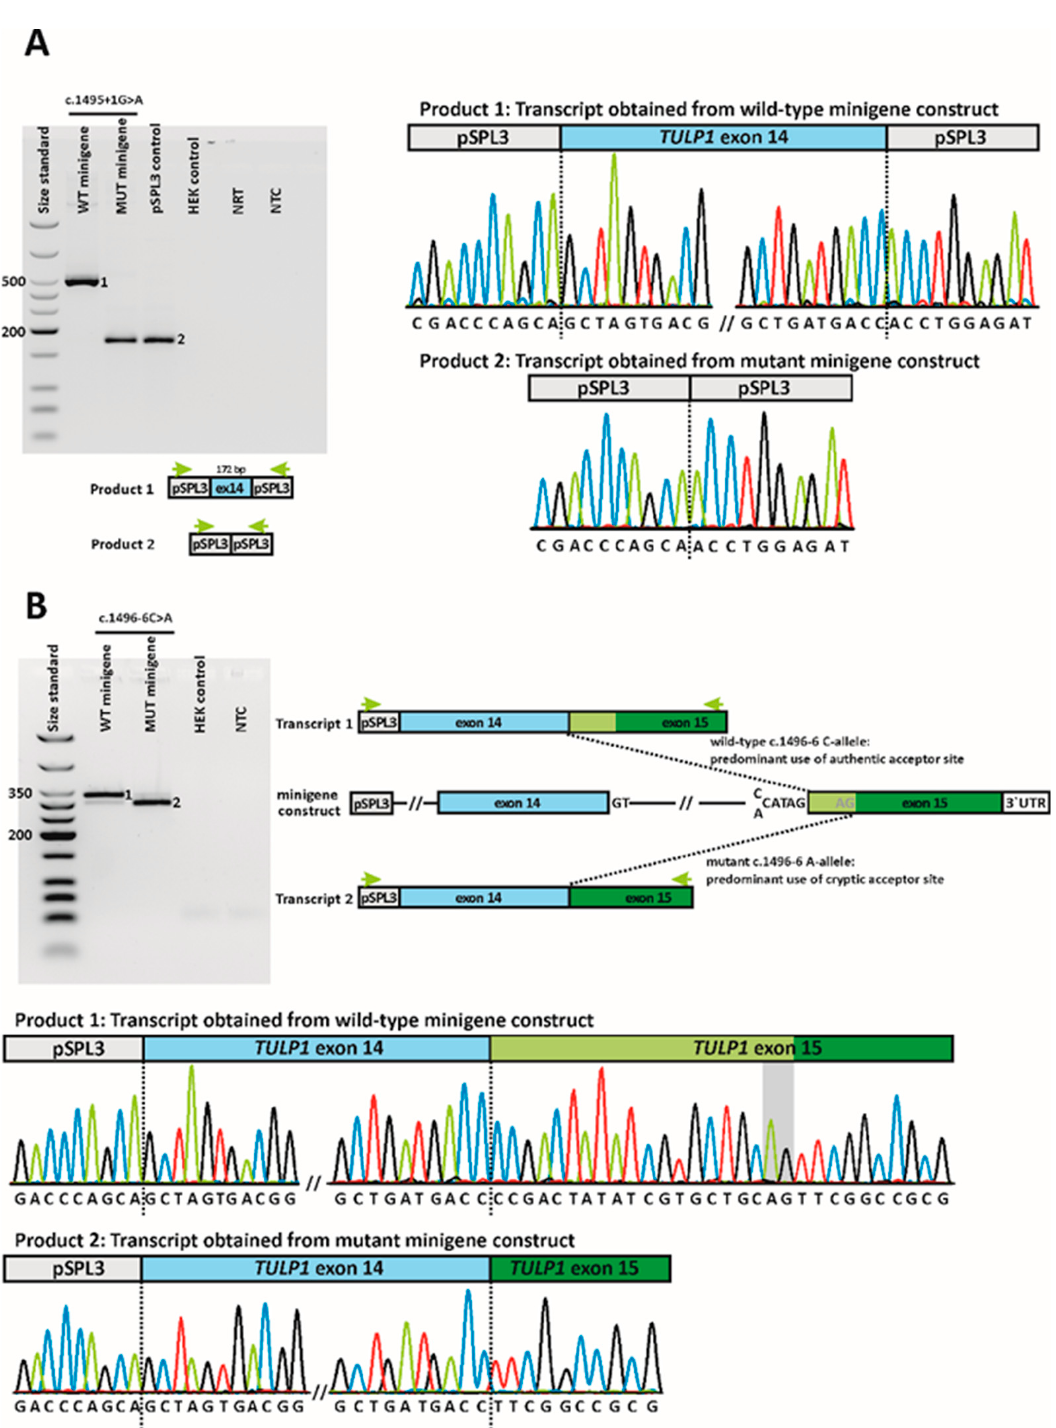
Figure 6. In vitro splice assays. ( A ) Variant c.1495+1G>A. Agarose gel electrophoresis of RT-PCR products is shown on the left. Leftmost lane, size standard (low molecular weight DNA ladder, NEB); lane 2, RT-PCR product of the wild-type allele; lane 3, RT-PCR product of the mutant allele; lane 4, transfection with empty pSPL3; lane 5, untransfected HEK293T cells; lane 6, no reverse tran- scriptase control (NRT); lane 7, no template control (NTC). Schemes of the amplified products are presented below the agarose gel. Gray boxes represent pSPL3 resident exons, and the blue box TULP1 exon 14, respectively. Green arrows indicate the location of the RT-PCR primers. Sequence